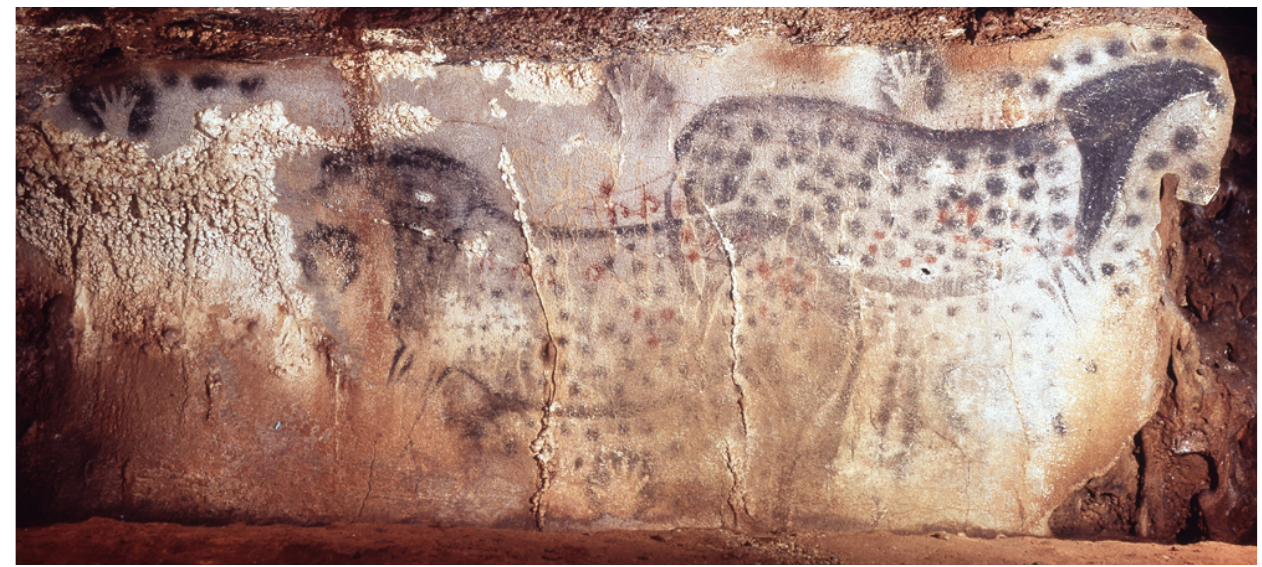
Figure 1. Spotted Horses Panel of Pech Merle Cave. Each horse 1.6 m. By permission Centre de Préhistoire du Pech